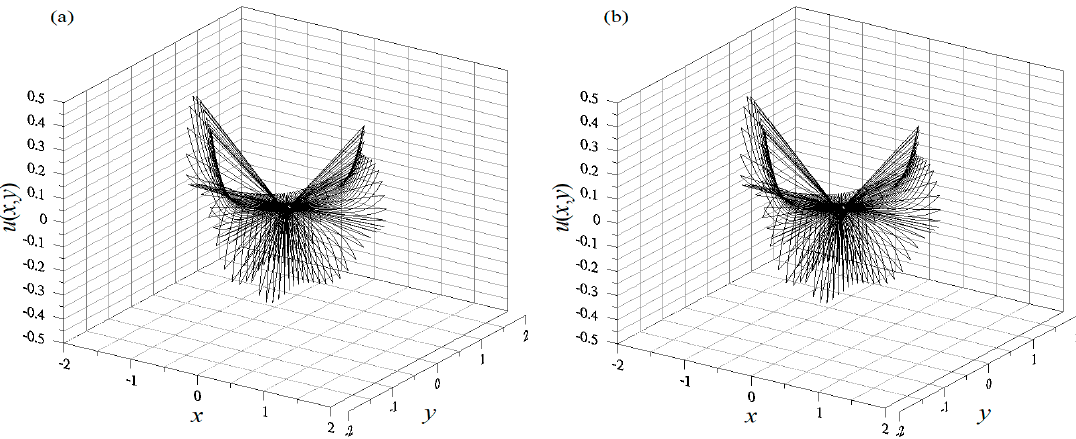
Figure 4. The exact solutions for the steady-state AC equation with Cassini-shaped domain are shown in ( a ), and in ( b ) the proposed approach solution without random noise.